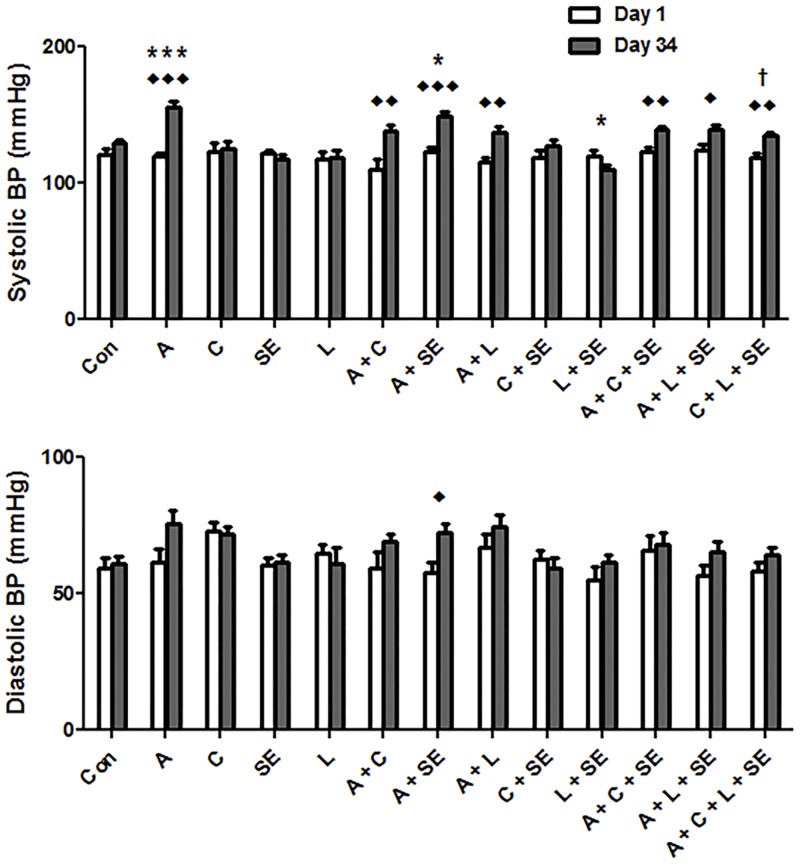
Systolic (SBP) and diastolic blood (DBP) pressure data.Control (Con) rats, rats treated with adenine (A) in the feed (0.25%W/V), curcumin (C, 75 mg/kg), or lisinopril (L, 10 mg/kg), separately or in combination, and subjected to swimming exercise (SE). The measurements were conducted on the first day of the experiment and one day before sacrificing the animals. Each column and vertical bar represents mean ± SEM (n = 6). ◆ Denotes significance of Day 1 vs. Day 34 of each experimental group: where ◆P < 0.05, ◆◆P < 0.001, ◆◆◆P < 0.0001. * denotes significance of different groups vs. Control group: where *P < 0.05, ***P < 0.0001. † Denotes significance of the group treated with A alone vs. its corresponding groups treated with A and subjected to SE: where †P < 0.05.